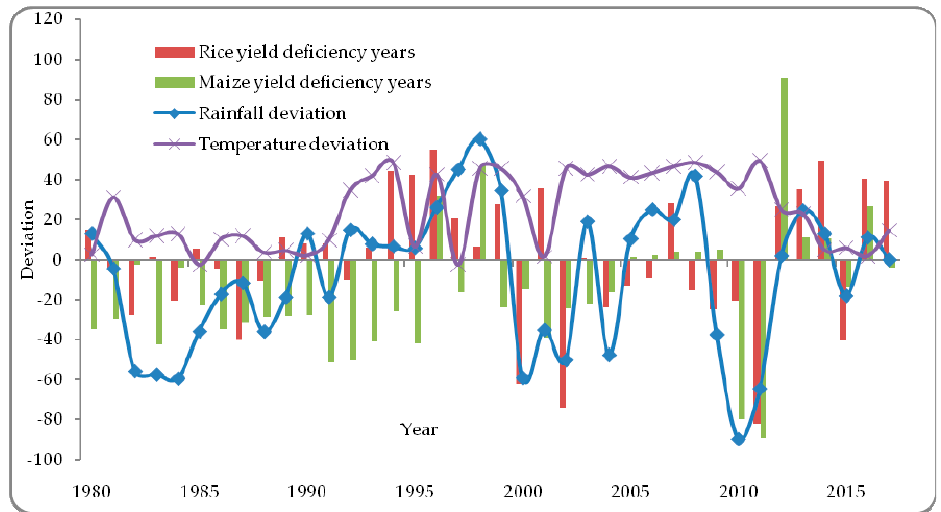
Figure 3. Relationship between rice and maize yield deficiency years, along with rainfall and temperature deviation years. Table 1. Years representing paddy and maize yield deficient years (>10%), along with rainfall and temperature deviation years.